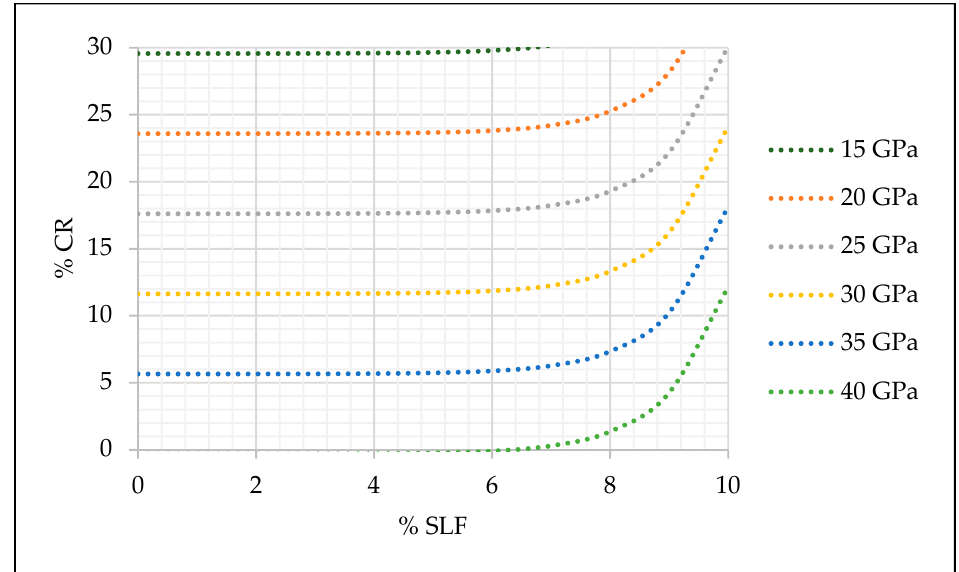
Figure 16. Prediction model for SCC modulus of elasticity (E = 39.7295 − 0.836401 × cr + 0.000473885 × exp(slf).